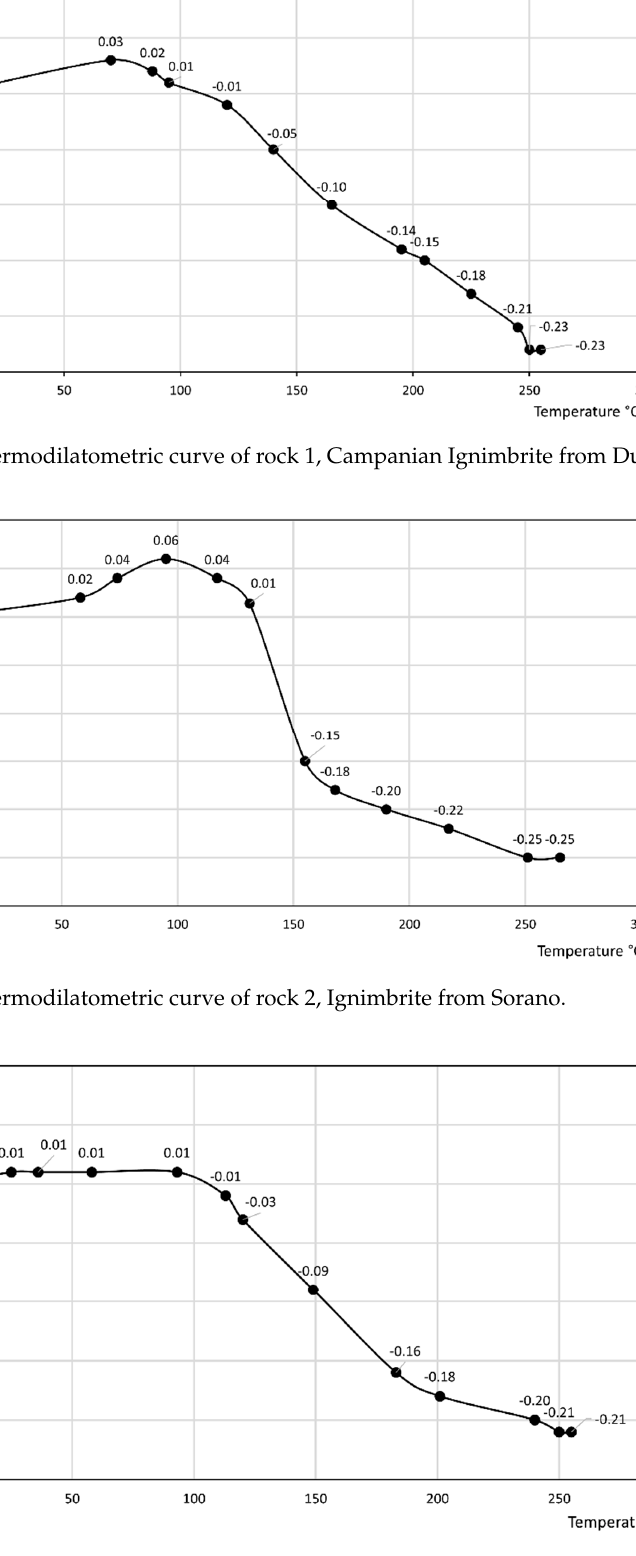
Figure 3. Thermodilatometric curve of rock 3, Campanian Ignimbrite from Comiziano.